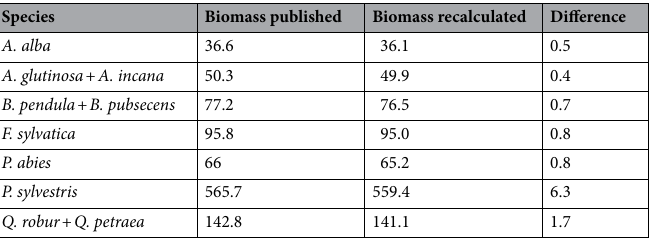
Table 4. Country-level stem wood and bark biomass published by Jabłoński and Budniak 39 , biomass recalculated using D coefficients (Table 3) and differences in biomass. All values in 10 6